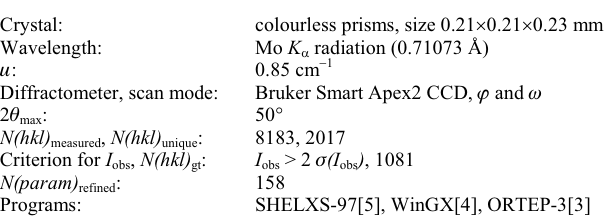
Table 1. Data collection and handling.